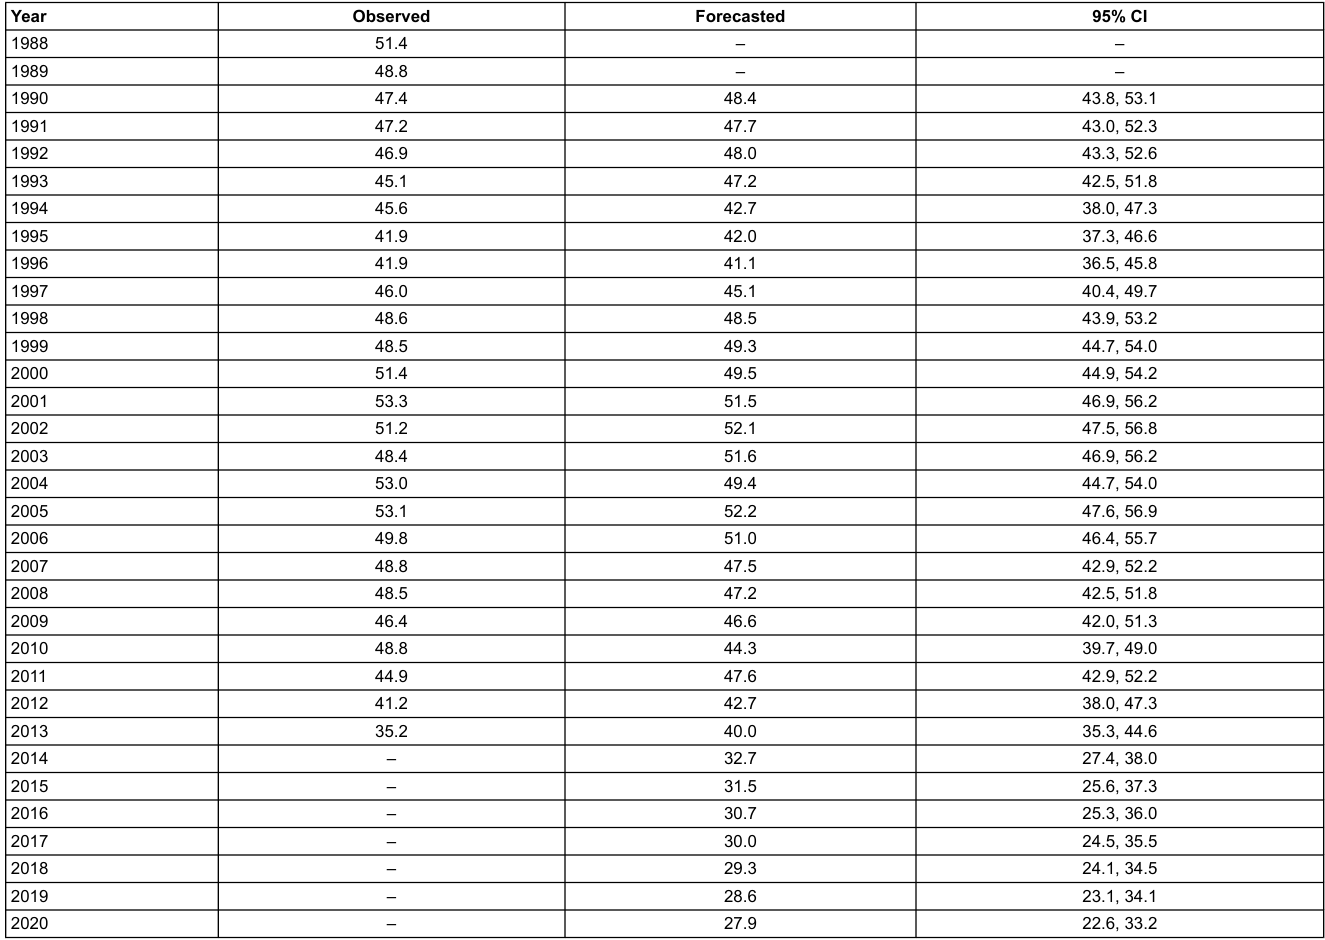
Table S2: Observed and forecasted recidivism